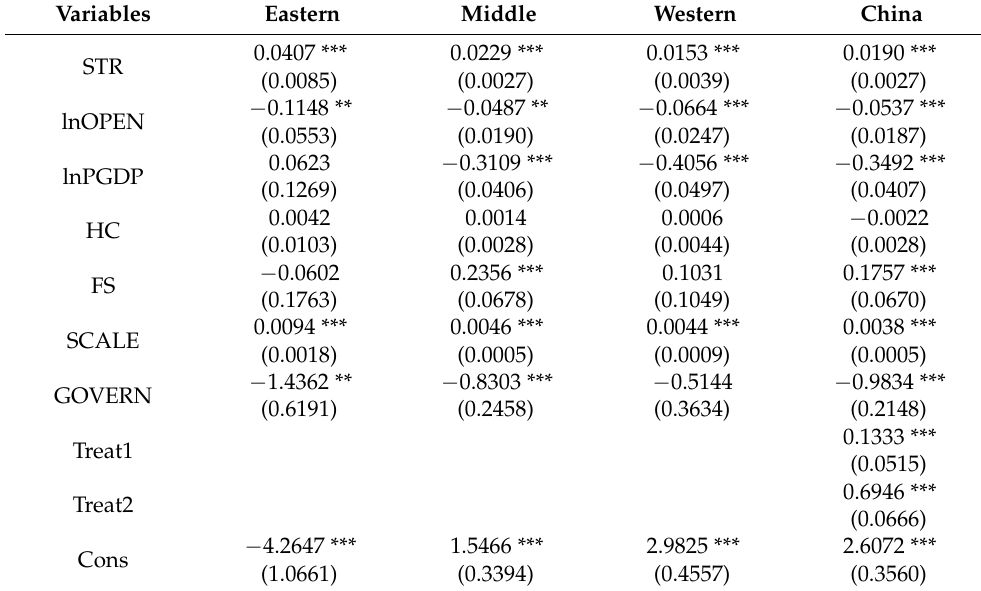
Table 4. Analysis of the differences in the influencing